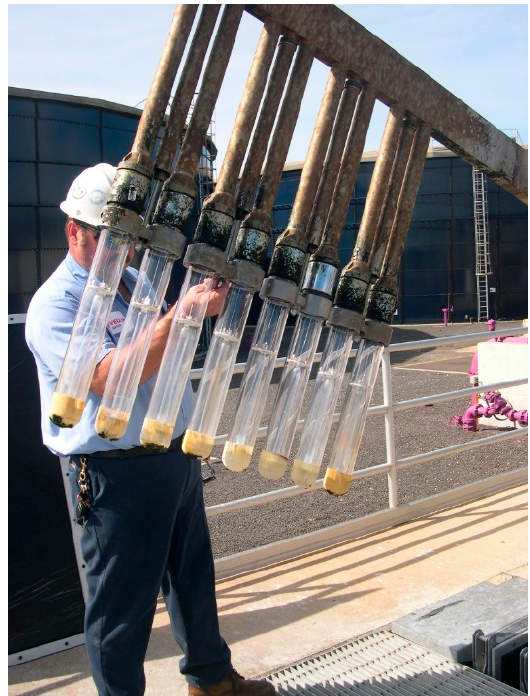
Figure 15. UV assembly from a basin reactor out for inspection and maintenance. Courtesy of Scrivener Publishing.